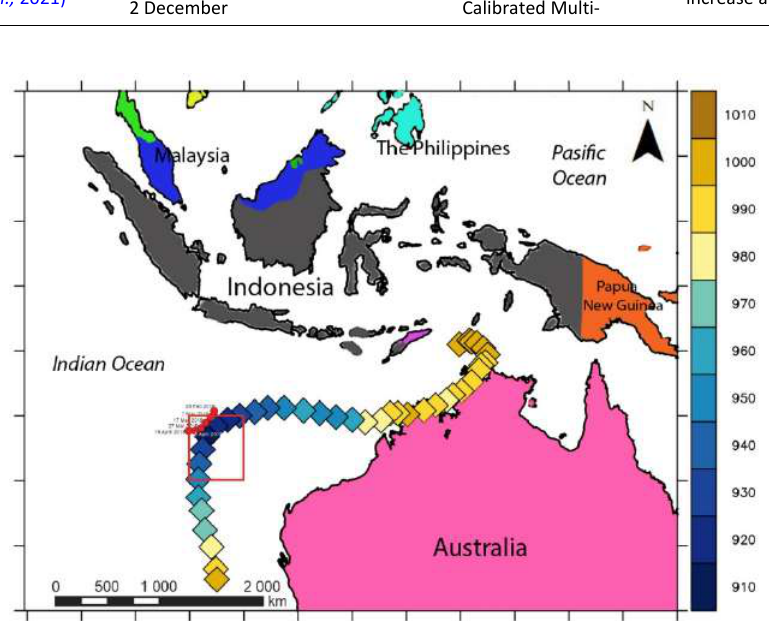
Fig 1 : Path of Cyclone Marcus during 14-24 March 2018 and pressure (color in hPa), while the red dots indicate the position of Argo Float stations. The red box shows the study area indicating the highest intensity (low-pressure area) of Cyclone Marcus